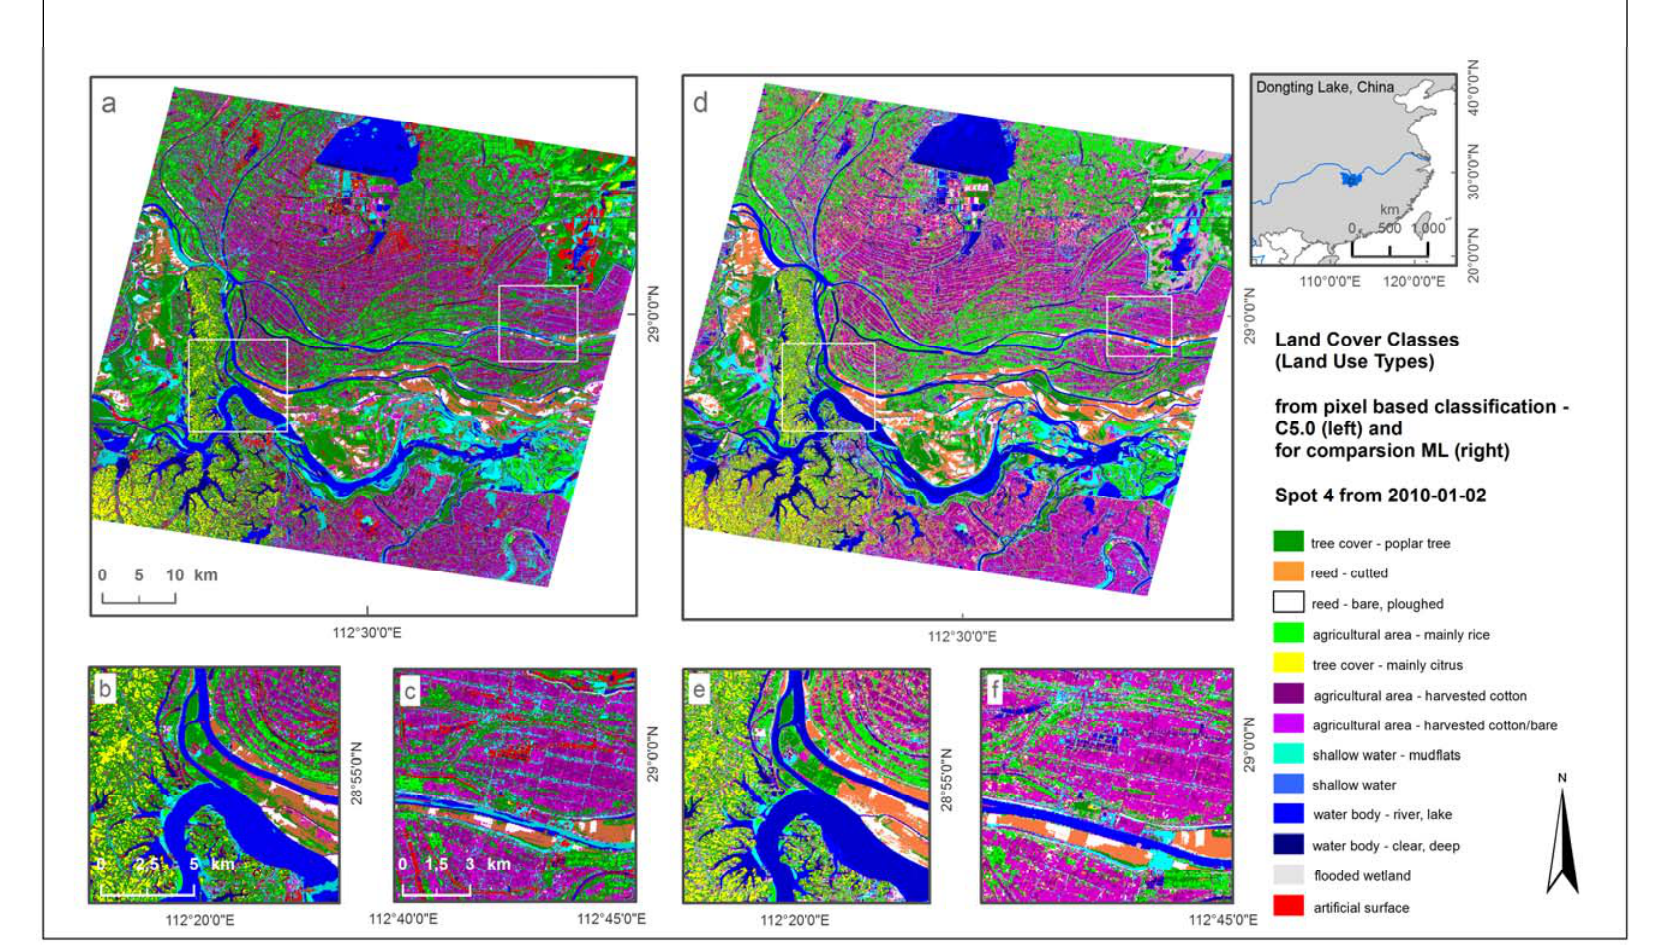
Figure 5. Classification result of TWOPAC run with SPOT 4 dataset (2010-01-02) from the Dongting lake, Hunan province, China: pixel-based result generated with C5.0 (( a ), details in ( b , c )); for comparison maximum likelihood classification (( d ), details in ( e , f